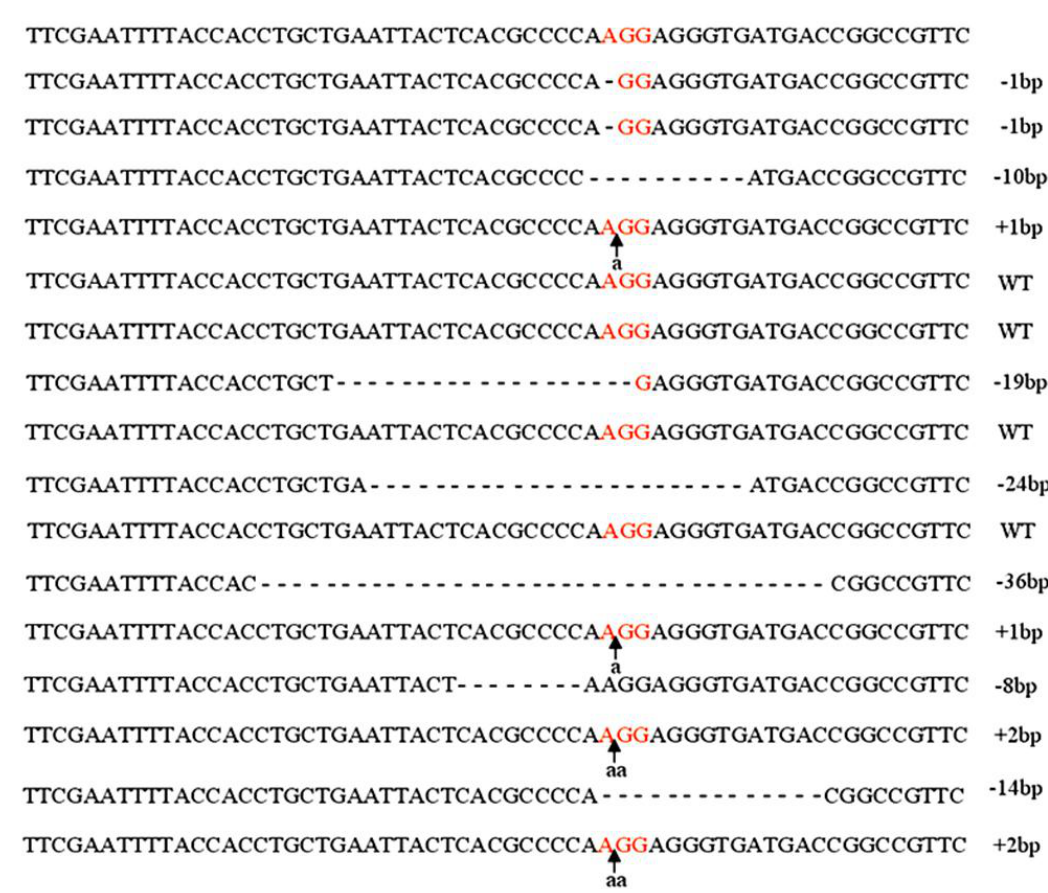
Figure 2. Identification of successfully targeted DNMT3B alleles in human iPS cells. Exon 19 of DNMT3B was PCR-amplified and subjected to sub-cloning and sequencing. Sequences of both alleles from a total of eight colonies are shown. The PAM sequences are shown in red, and the lowercase letters indicate insertion